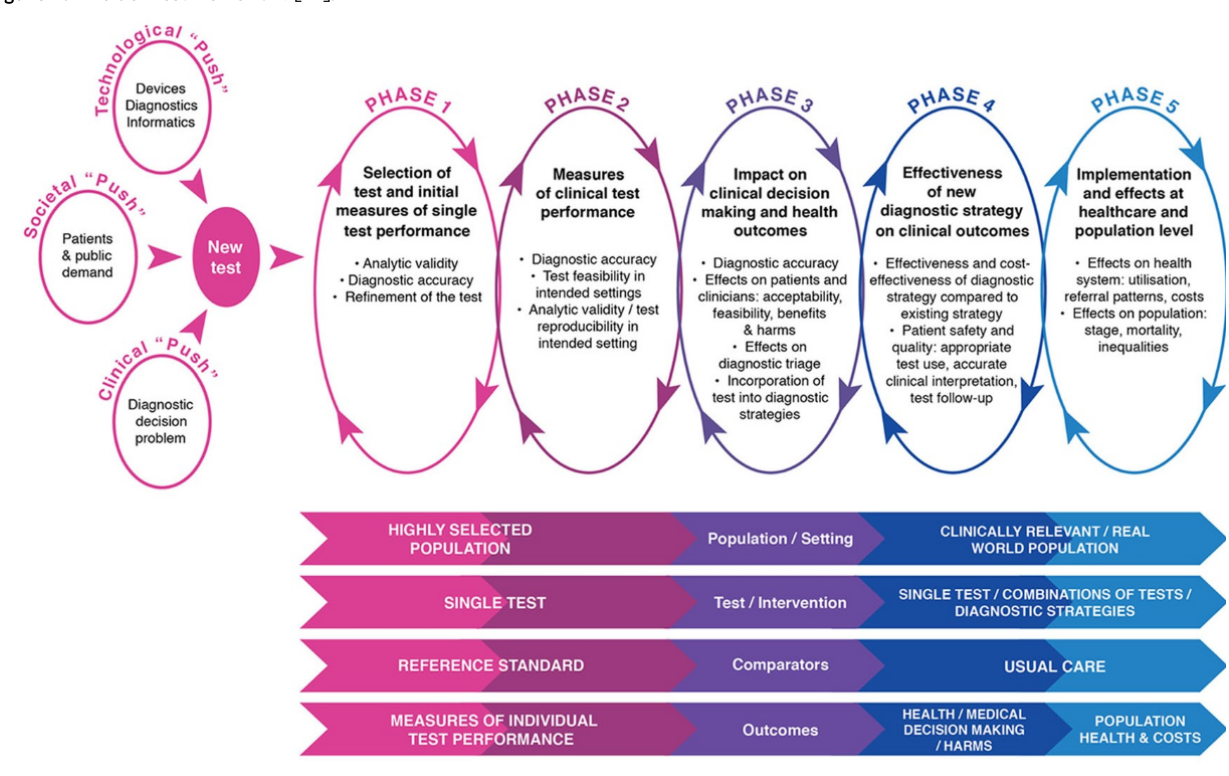
Figure 1. The CanTest Framework